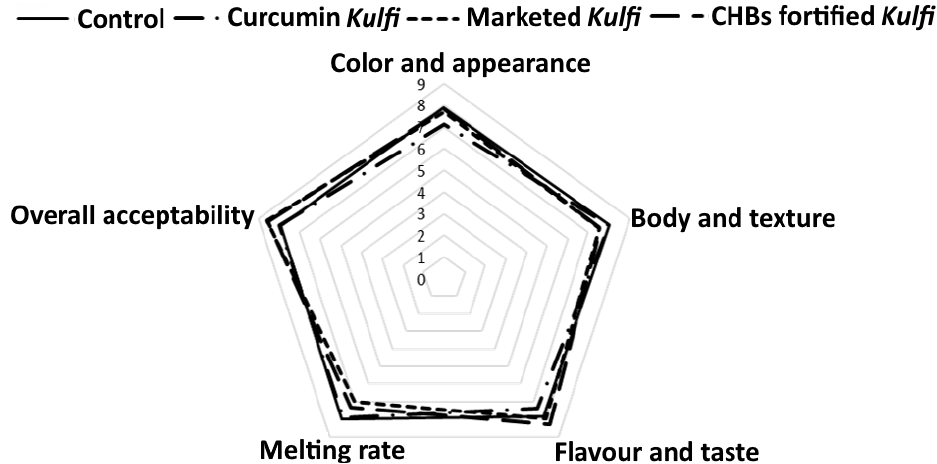
Figure 6. Sensory analysis of Kulfi fortified with CHBs. Hedonic scale: 9 = like extremely, 5 = neutral, and 1 = dislike extremely; CHBs, curcumin hydrogel beads.